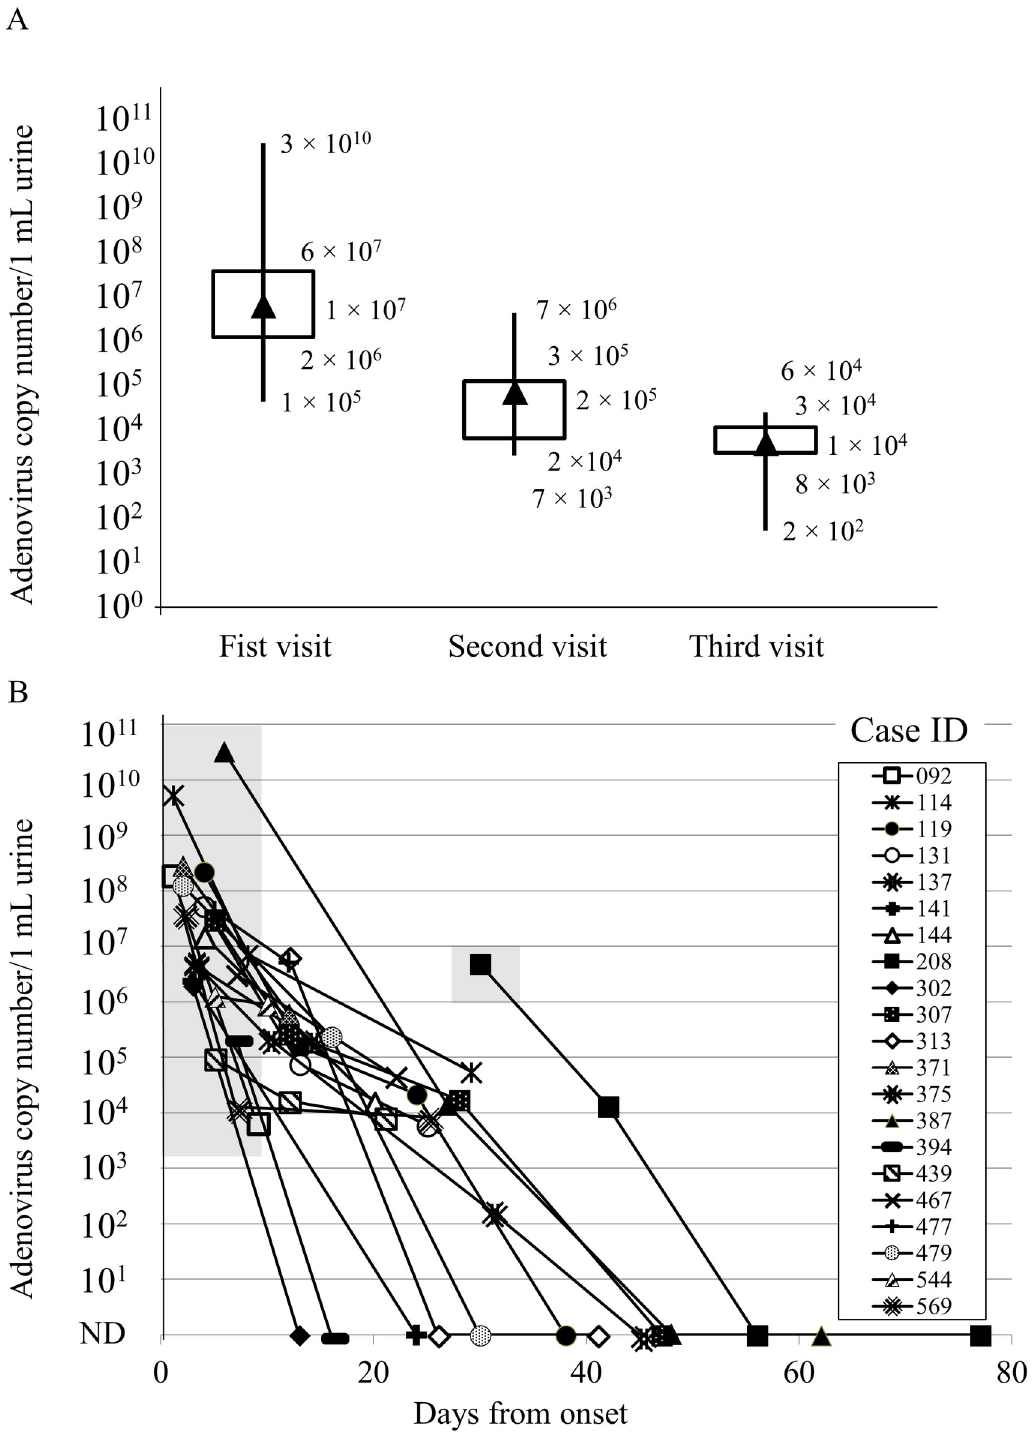
Fig 3. Changes in the number of HAdV copies over time. A. Changes in the HAdV genome copy number at the initial, second, and third visits. Cases in which no virus was detected were excluded. The upper panel shows the maximum, 1st interquartile (25%), 2nd interquartile median (50%, black triangle), 3rd interquartile (75%), and minimum values for the number of viral copies. The Y-axis indicates the number of viral copies per 1 mL of urine. B. Number of viral DNA copies at estimated number of days from onset. Changes in virus levels in cases that could be tested are indicated by solid lines. ND indicates not detected. Gray area shows the period during which symptoms were present. Symptoms were observed from days 1 to 10 in all cases, except for